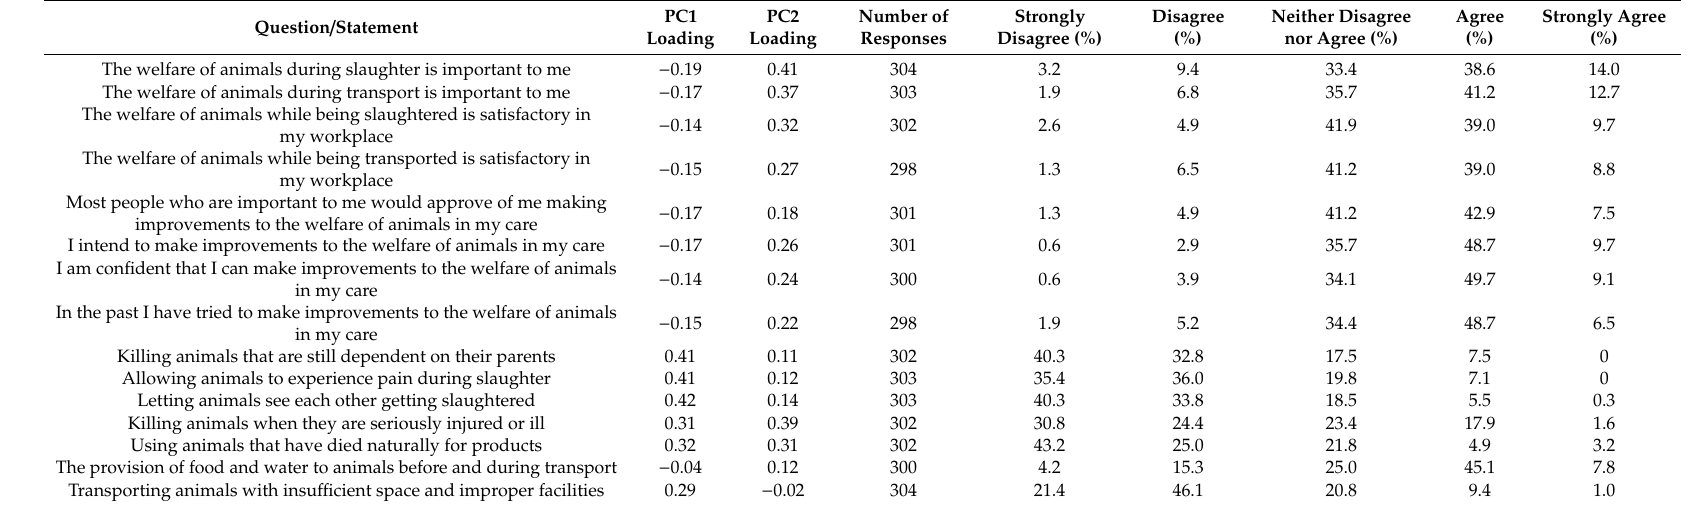
Table 4. Responses to attitudinal questions. Loadings on Principal Components 1 and 2, Number of valid responses, and percentage of